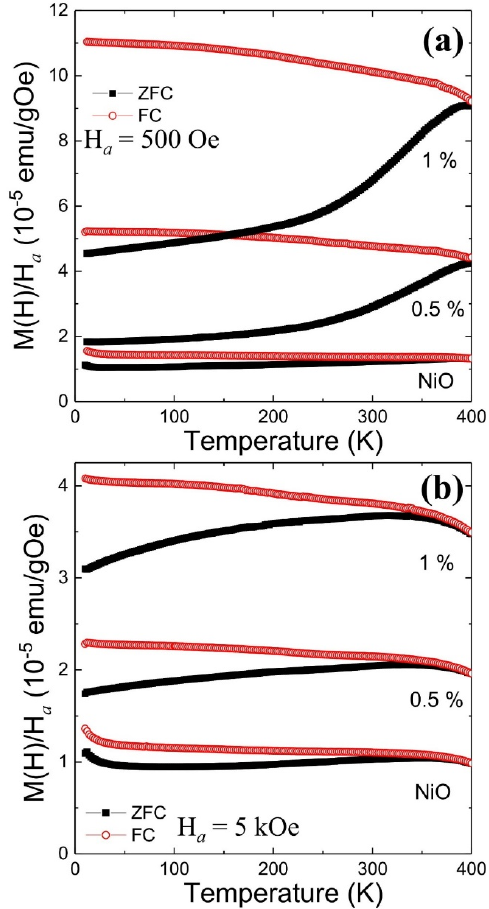
Figure 4. ( a , b ) M(H) / H a vs. T plots for NiO, 0.5, and 1% samples measured using ZFC and FC protocols at external fields H a of 500 Oe and 5 kOe, respectively.